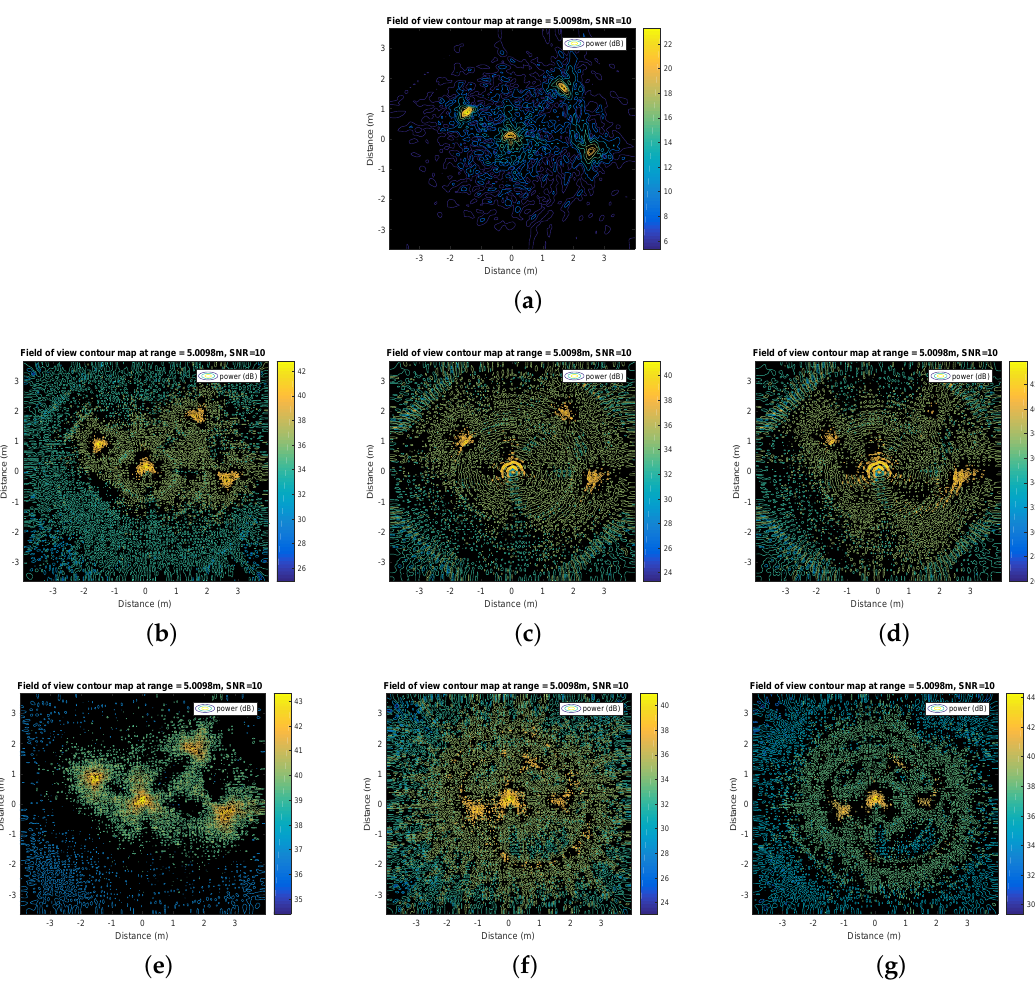
Figure 6. Simulation results (front view from radar panel at 5 m, the x axis and y axis are azimuth and elevation distance from the center, respectively). ( a ) Inverse Radon transform (IRT) method with the perfect setup; ( b ) compressed sensing (CS) applying Equation (38) to the angle profile with R CS = 1/2; ( c ) CS applying Equation (39) to the angle profile with R CS = 1/2; ( d ) CS applying Equation (40) to the angle profile with R CS = 1/2; ( e ) CS applying Equation (38) to the slow-time profile with R CS = 1/2; ( f ) CS applying Equation (39) to the slow-time profile with R CS = 1/2; ( g ) CS applying Equation (40) to the slow-time profile with R CS =